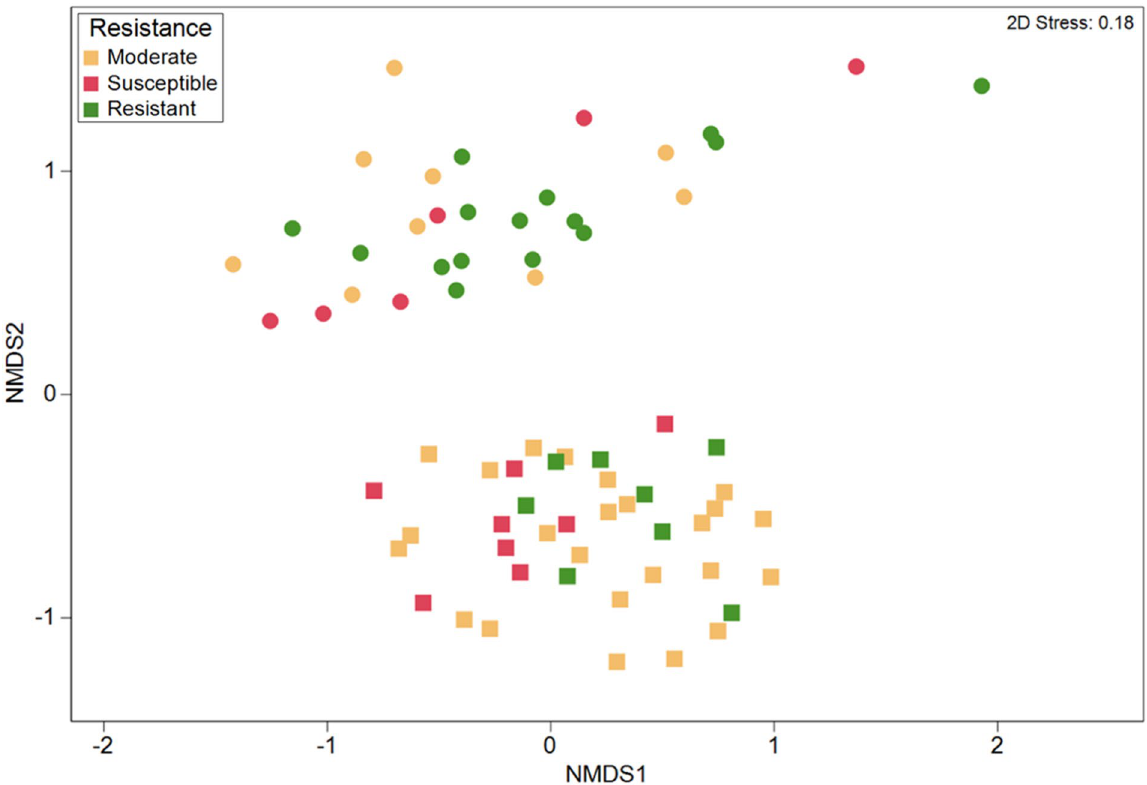
Figure 5. Non-metric multidimensional scaling (NMDS) ordinations based on the Bray–Curtis similarity of bacterial and archaeal OTU community structure among strawberry cultivars exhibiting different resistance against Verticillium dahliae (squares) and Macrophomina phaseolina